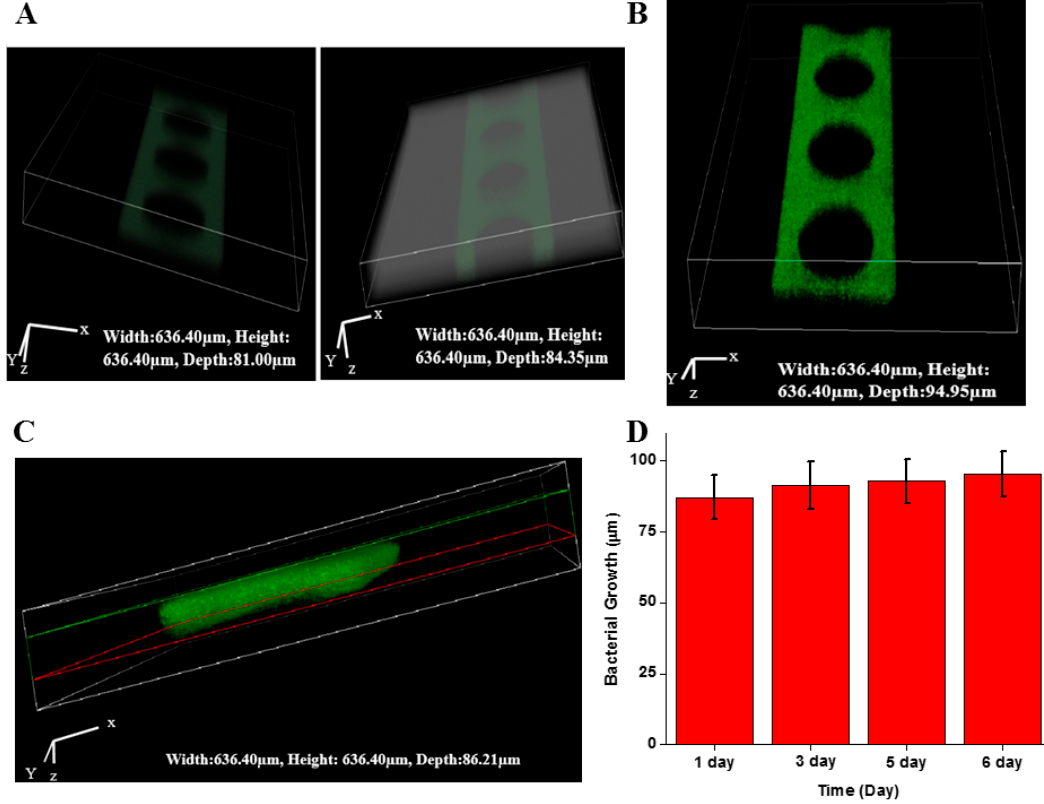
Figure 3. Analysis of biofilm formation in the microfluidic sensor.( A ) 3D images after 12 h (left) and 24 h (right); ( B ) 3D image after 6 days; ( C ) analysis of P. aeruginosa biofilm thickness using confocal microscopy (red line indicates the actual biofilm thickness); and ( D ) time-dependent analysis of biofilm thickness.